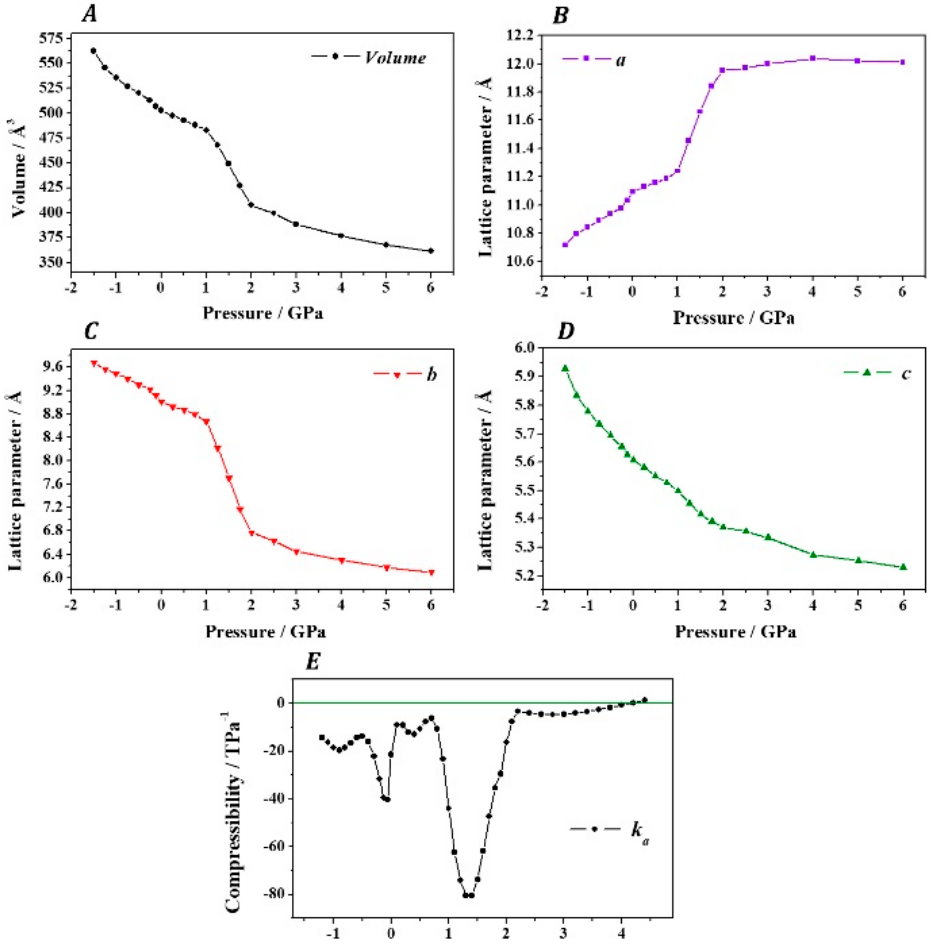
Figure 5. ( A ) Computed unit cell volume of copper squarate as a function of the applied isotropic pressure; ( B ) a lattice parameter; ( C ) b lattice parameter; ( D ) c lattice parameter; ( E ) Compressibility along [1 0 0] crystallographic direction, k a = − 1/ a · ( ∂ a / ∂ P ) P